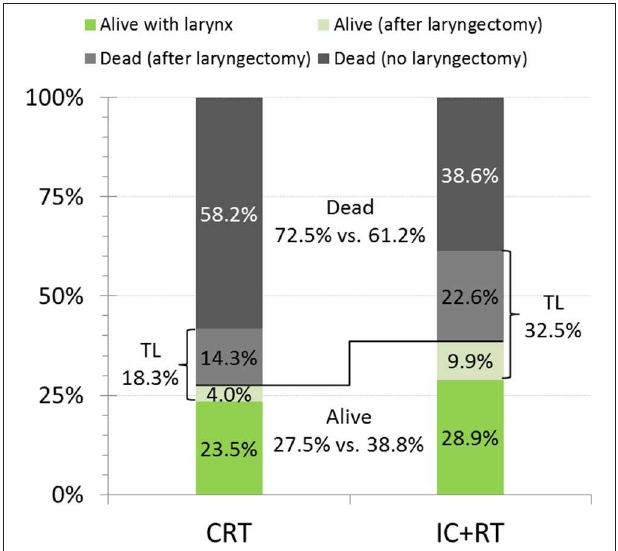
FIGURE 1 | Ten-years outcome data of patients treated with concomitant cisplatin radiotherapy (CRT) vs. induction-chemotherapy with cisplatin and 5-fluorouracil followed by radiotherapy (IC + RT) in the Radiation Therapy Oncology Group (RTOG) phase III randomized clinical trial RTOG 91–11 demonstrates superior long-term survival and survival with larynx despite increased frequency of total laryngectomies (TL). Modified representation of data from Forastiere et al. (1) according to Licitra et al.